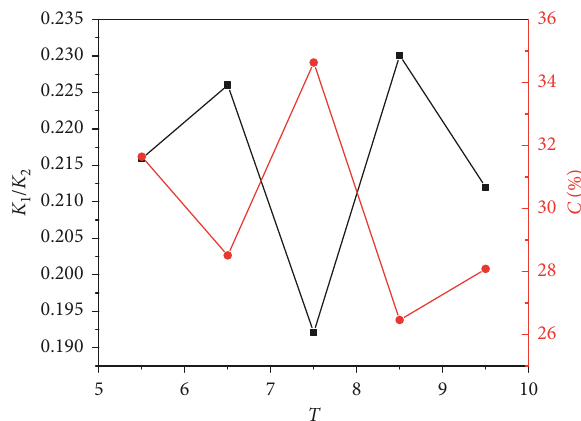
Figure 9: The stiffness-damping characteristics of the GGQ-99 WRI with different pitch lengths of wire